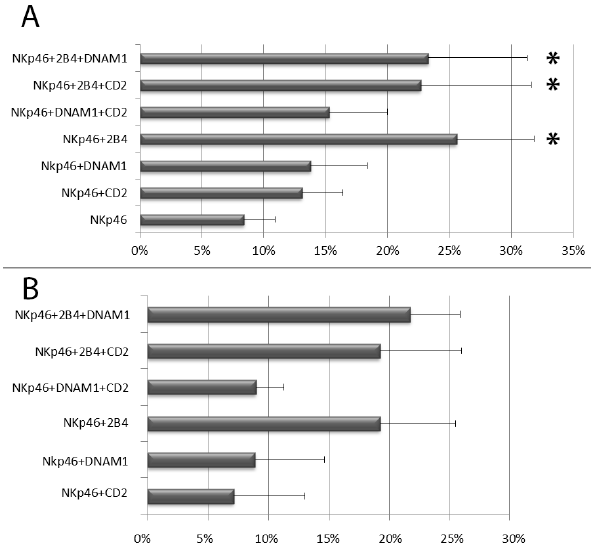
Figure 2. Degranulation analysis of resting peripheral blood NK cells after stimulation with the indicated mAb combinations. ( A ) Percentages of degranulating NK cells. ( B ) Percentage increment of CD107a mean fluorescent intensity on degranulating NK cells stimulated with the indicated combinations respect to anti-NKp46 alone (used as reference, see MM section where the method for calculation of increments is discussed). Data represent mean +/- SD of at least 5 experiments. Bars indicate SD. * p < 0.05 relative to NK cells stimulated with anti-NKp46 mAb-coated beads.